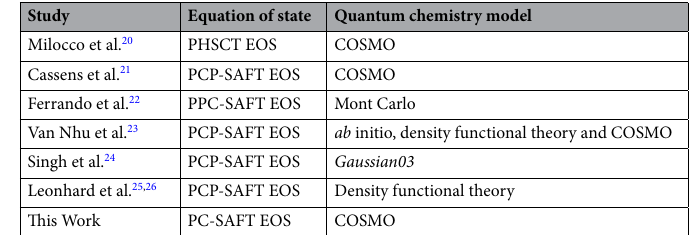
Table 1. A list of recent studies on performing the predictive EOS based on quantum chemistry.